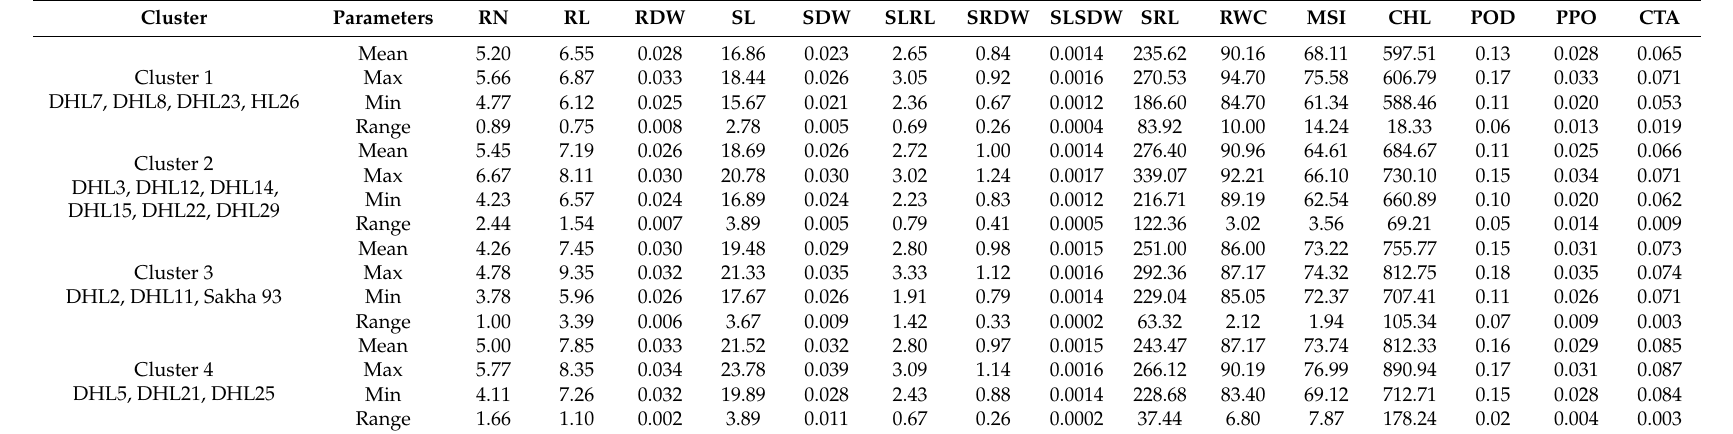
Table 5. Cluster membership, mean, maximum, minimum, and range for 15 measured traits of each